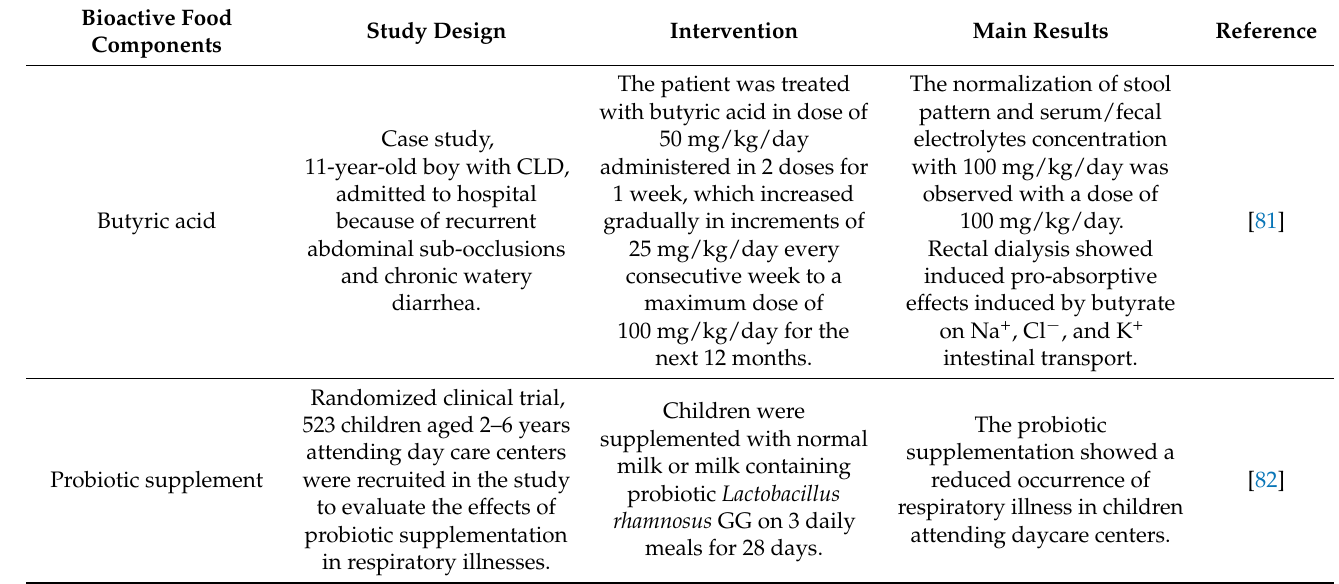
Table 2. Evidence of bioactive food supplementation in children from clinical trials. Bioactive